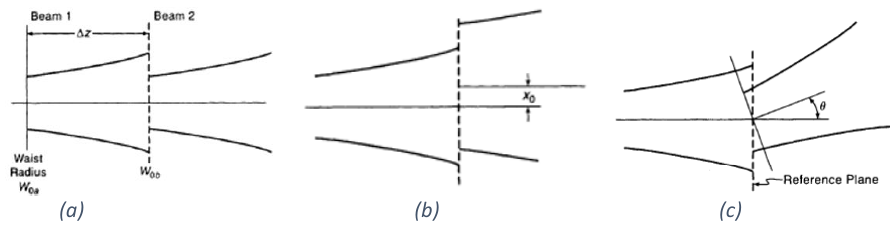
Figure 3: (a) Axially aligned beam with offset waist, (b) Offset Beams and (c) Tilted Beams Here we have considered only the first two cases, as the third case of tilted beam is not